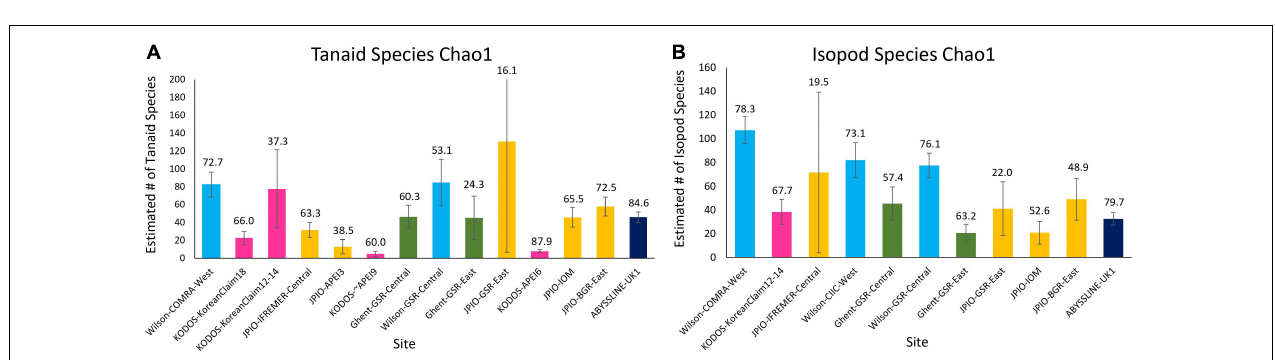
FIGURE 8 | Mean (A) tanaid and (B) isopod species accumulation as a function of number of box-core samples (UGE plot from EstimateS, 100 permutations) at different sites in the CCZ region. Note that the Korean Claim data come from a single site sampled in different years. Data sets considered to have been sampled with similar protocols and to have used a consistent taxonomy, are indicated by similar symbols.